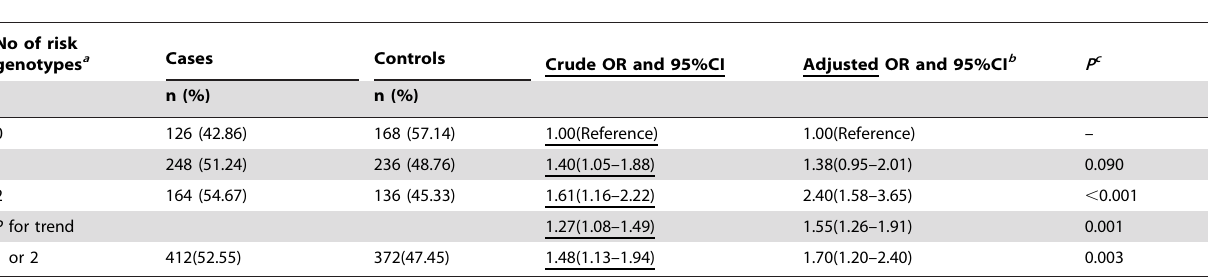
Table 2. Cumulative effect of adverse genotypes in PNPLA3 rs738409 and rs139051 on NAFLD.